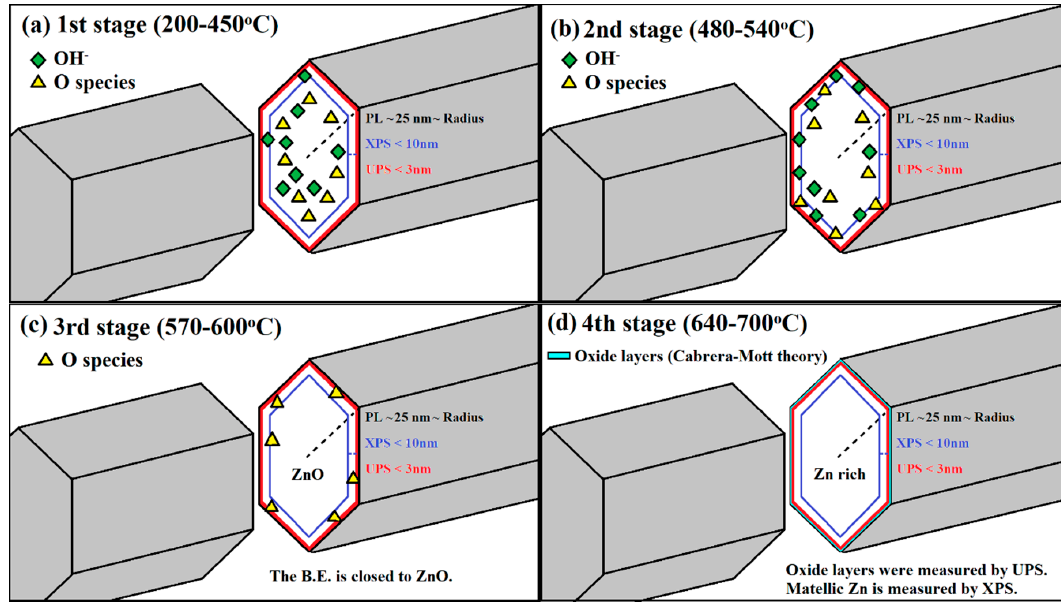
Figure 6. The similarities and dissimilarities between XPS and UPS ( a ) the first stage (200–450 °C): the surface adsorption on ZNRs was eliminated. ( b ) The second stage (480–540 °C): OH − diffuse and oxygen slower migrate to the surface of ZNRs. ( c ) The third stage (570–600 °C): remained migrated-oxygen atoms still halted on the top surface of completed ZNRs. ( d ) The fourth stage (640–700 °C): oxidation process occurred at the top surface layer of Zn-rich ZNRs.